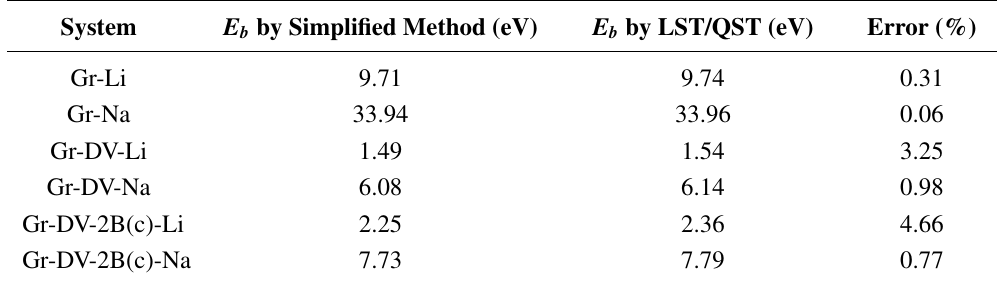
Table 1. Comparison of energy barriers ( E ) obtained by simplified and complete linear and b quadratic synchronous transit (LST/QST) method for a few representative systems.